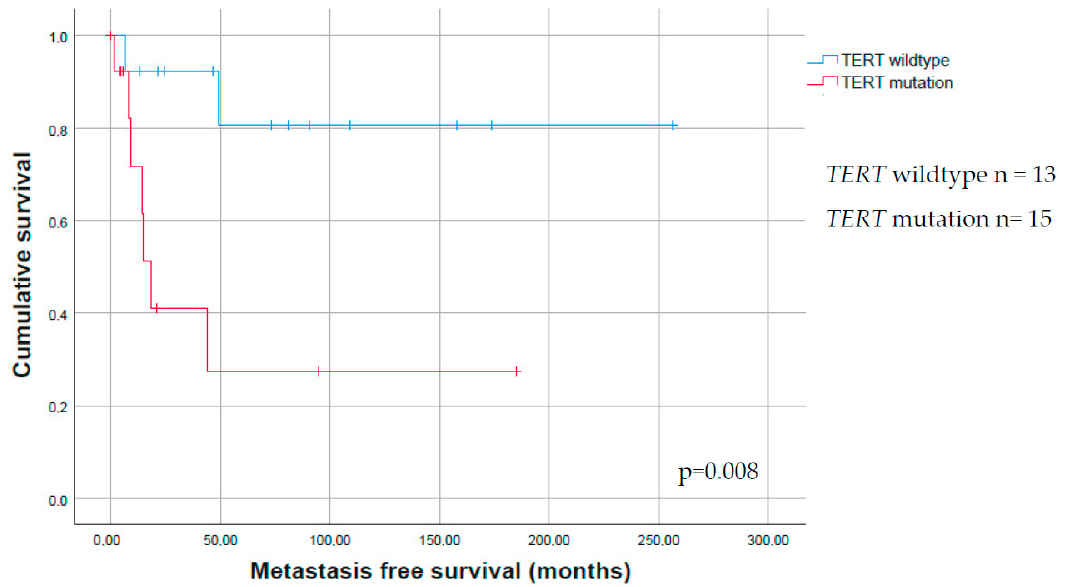
Figure 2. Kaplan–Meier survival estimate for the presence of a TERT promoter mutation in conjunctival melanoma. Kaplan– Meier survival estimate for the time to metastasis of conjunctival melanoma (CM), showing that patients with a CM with a TERT promoter mutation are more likely to develop metastatic